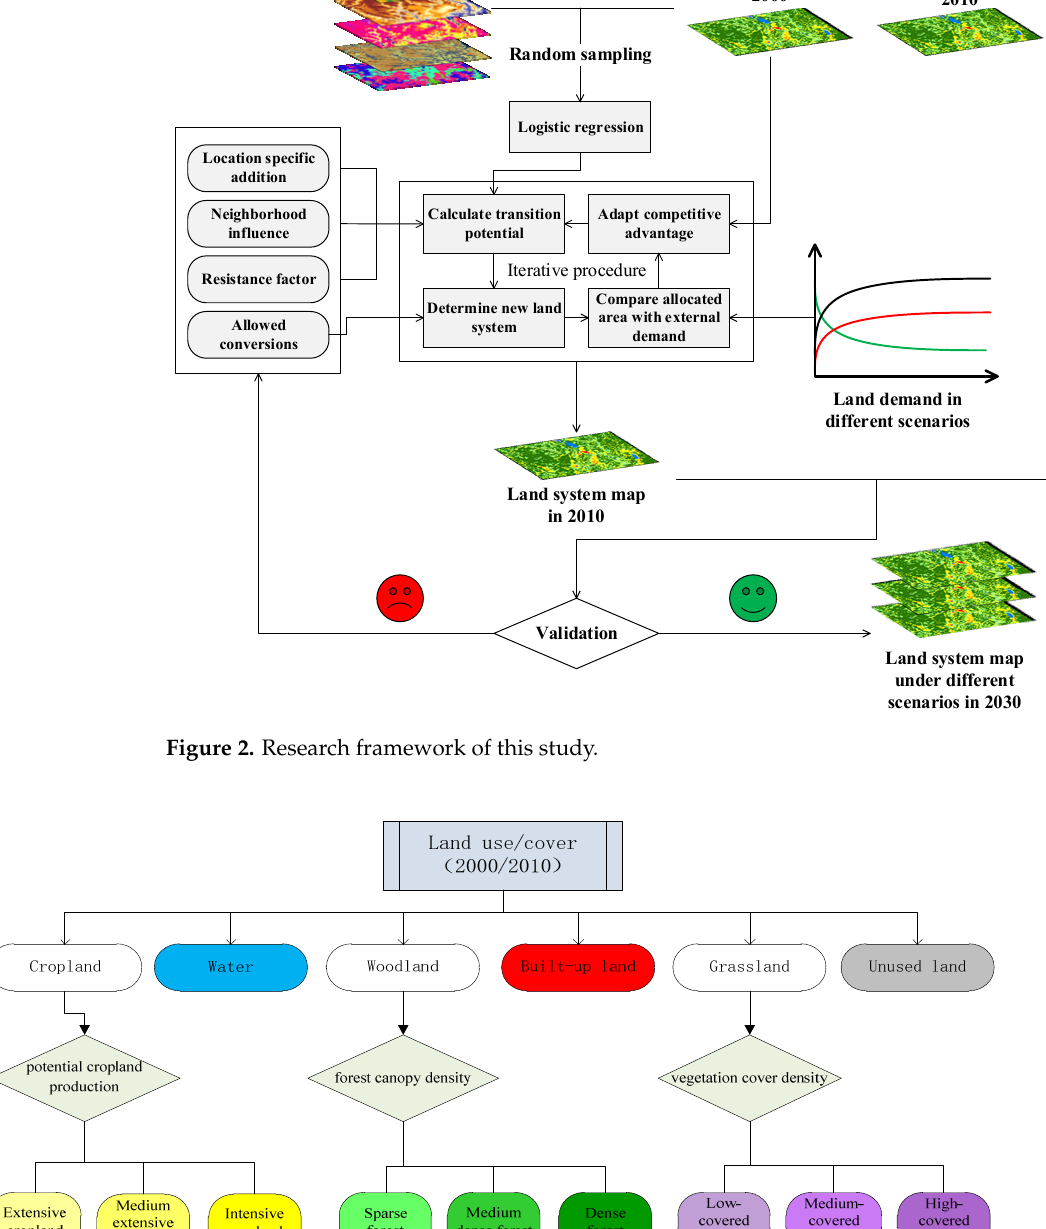
Figure 3. Approaches to land system delineation.